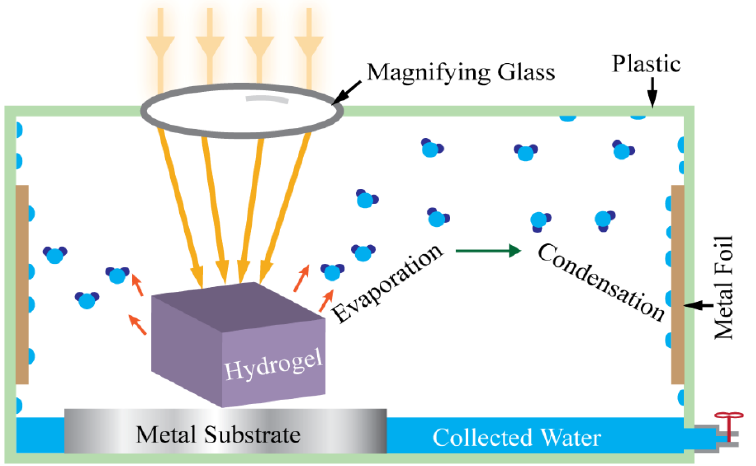
Figure 4. Schematic view of solar photothermal-assisted atmospheric water vapor collection device.